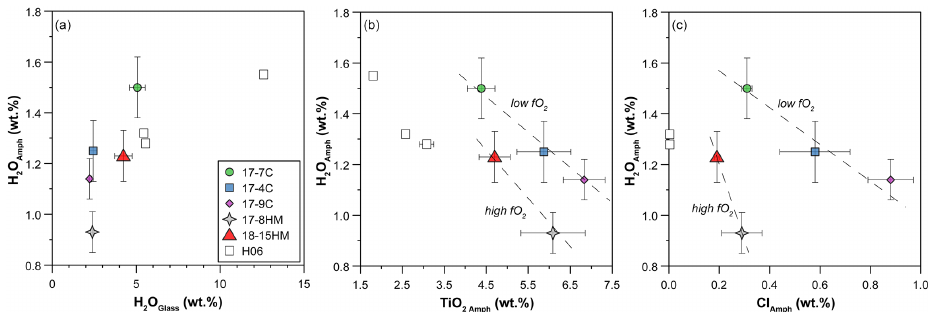
Figure 7. (a) Relation between H 2 O contents (wt%) in amphiboles and quenched melt. Correlation between H 2 O content (wt%) in amphi- bole and its TiO 2 (b) and Cl (c) contents (wt%). In (c) two separated correlations are visible based on the f O 2 of the system (dashed lines are a visual guide). H06: data from Hauri et al.